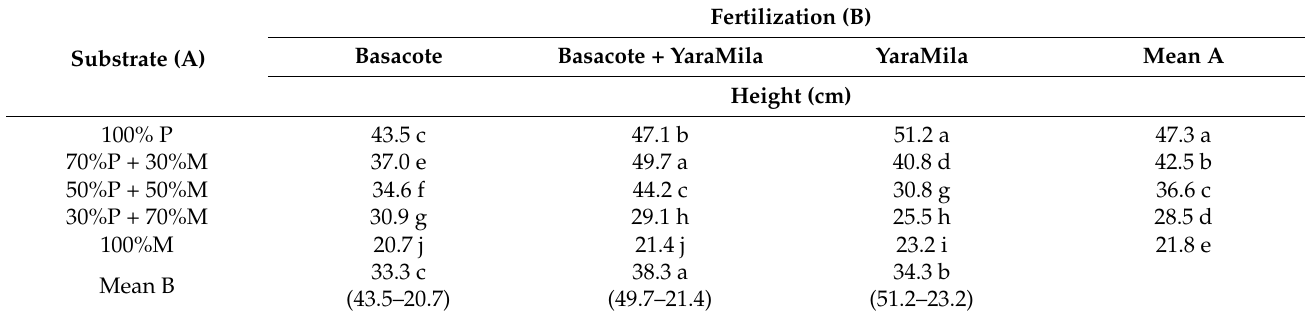
Table 2. Selected biometric features of Hydrangea arborescence ‘Annabelle’ grown in containers with five different